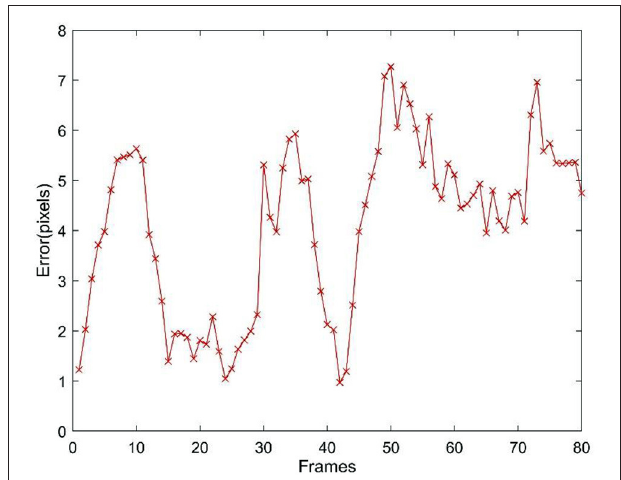
FIGURE 9 | Tracking errors of the SiamFC